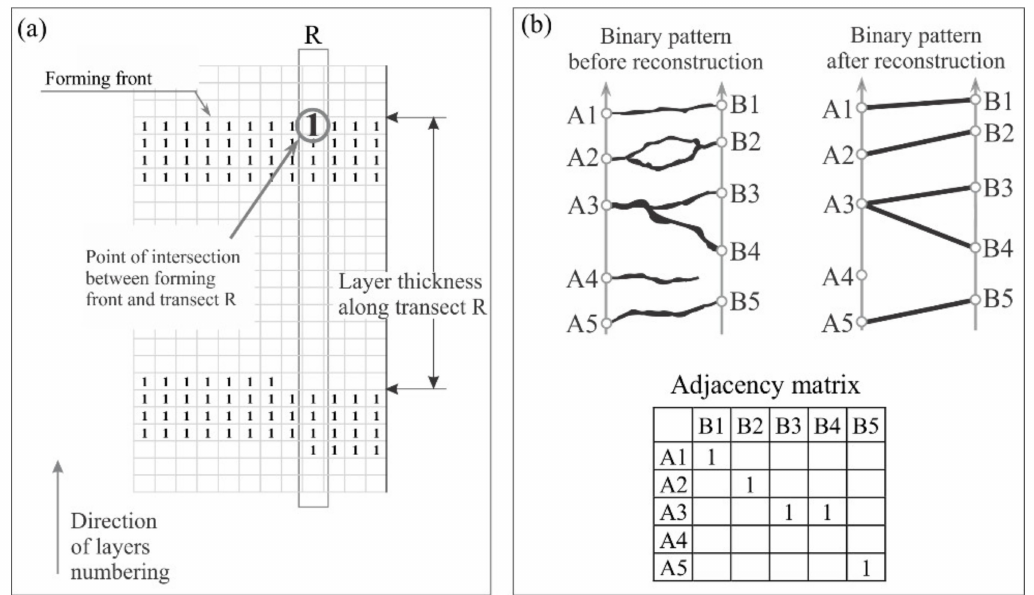
Figure 5. Pattern reconstruction from EM. ( a ) Principal elements of binary layered patterns: (1) direction of the numbered layers; (2) forming front; (3) layer thickness; (4) point of intersection between the forming front and transect R. ( b ) Pattern before and after reconstruction and its adjacency